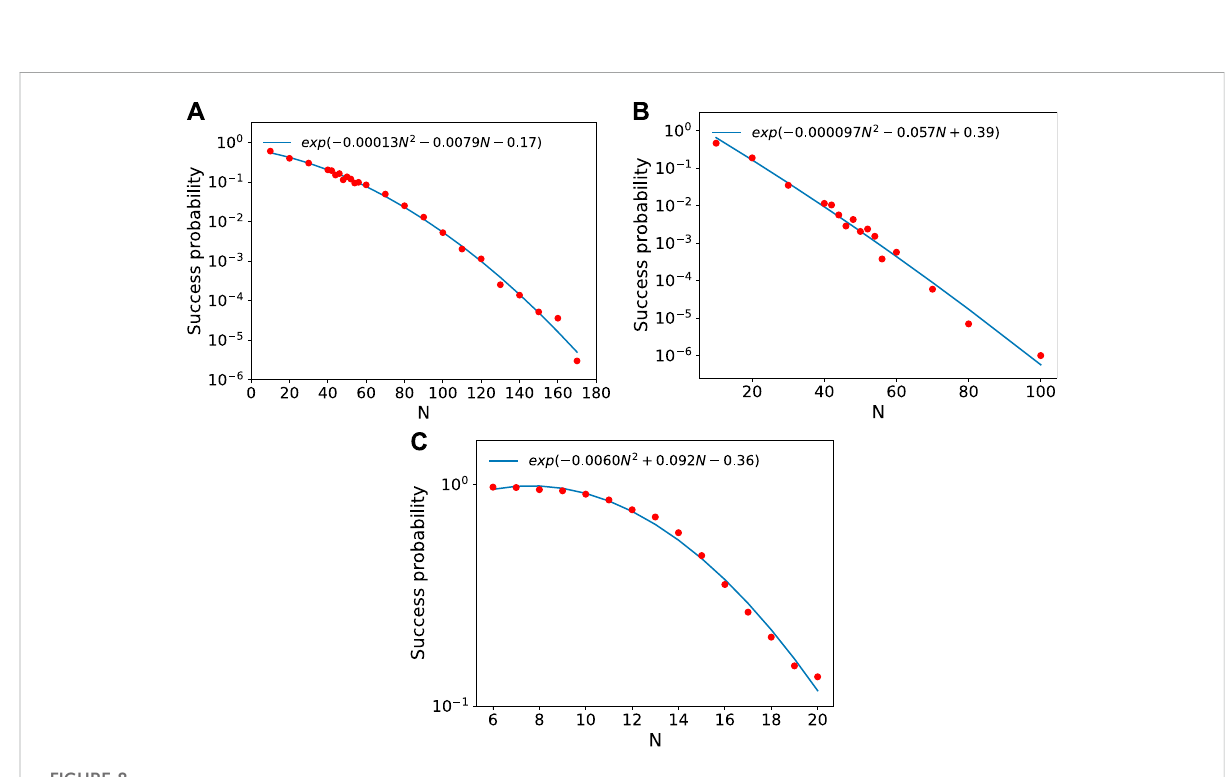
FIGURE 8 (color online) Scaling of success probability for (A) REG, (B) RAN, and (C) 2SAT classes of problems by fi tting exponential functions of second degree polynomial in N